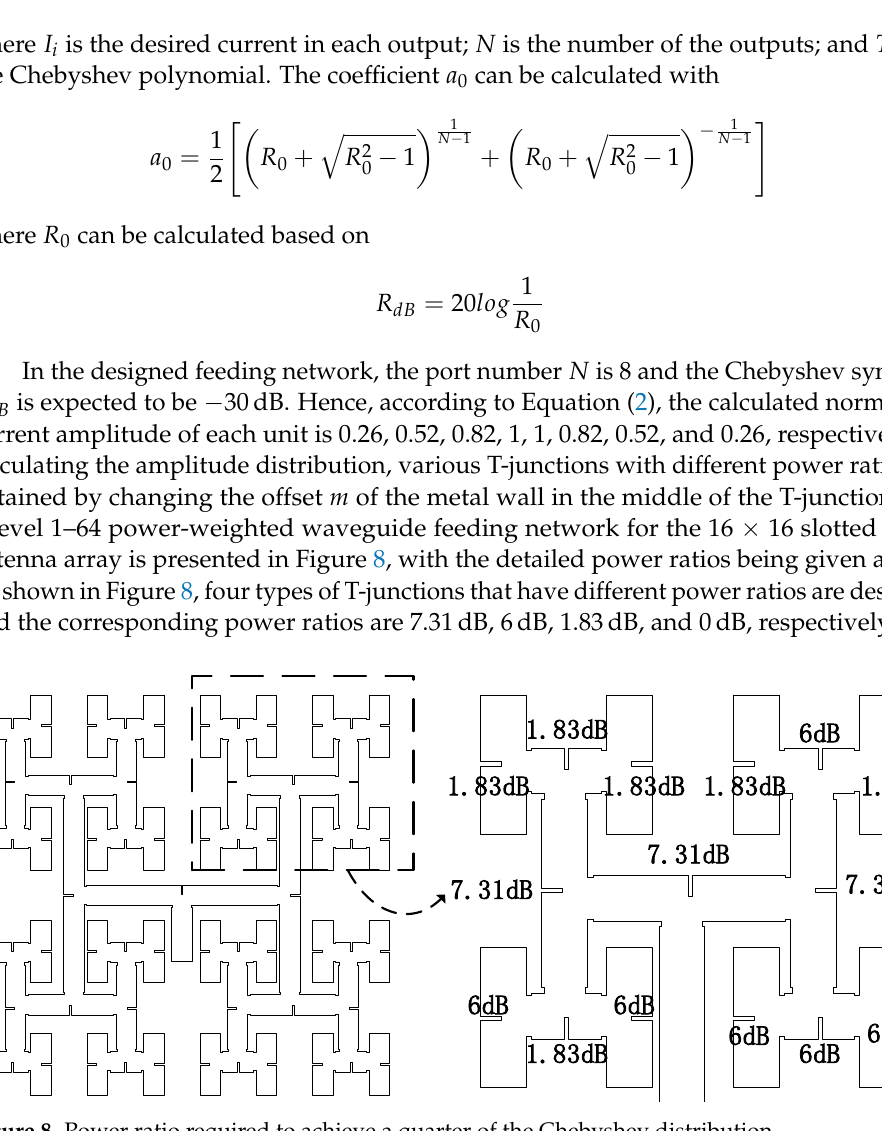
Figure 8. Power ratio required to achieve a quarter of the Chebyshev